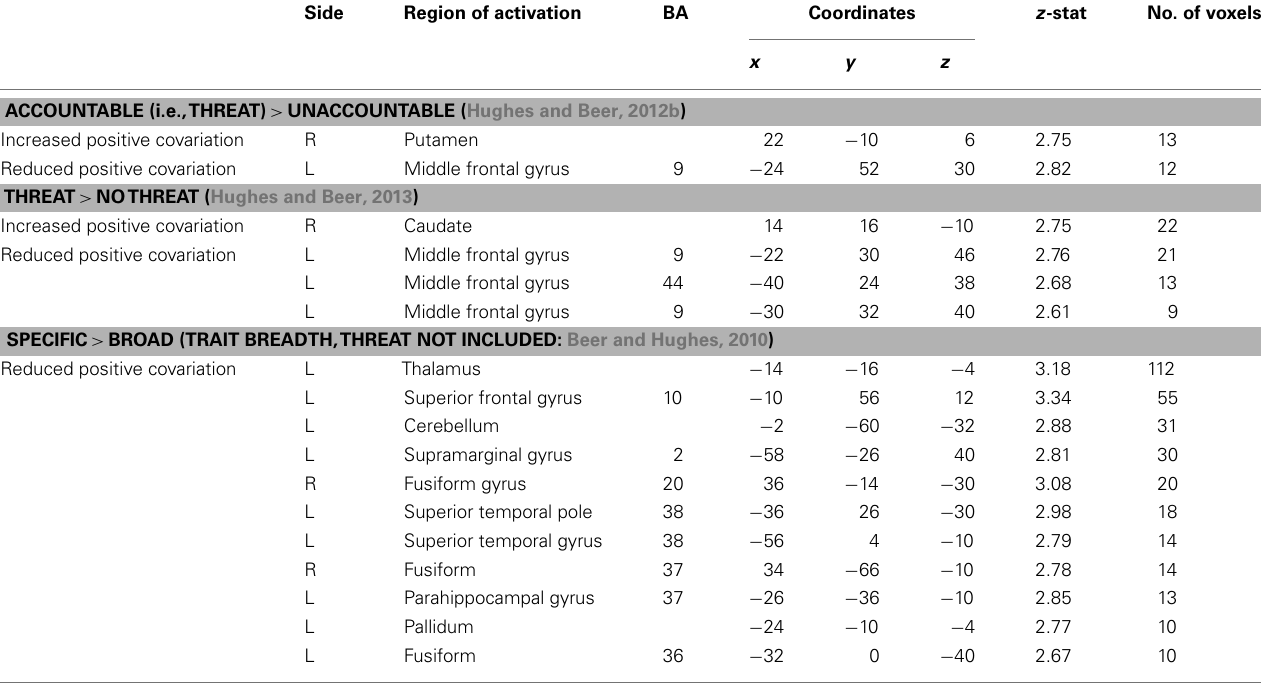
Table 2 | PPI connectivity analyses with MOFC